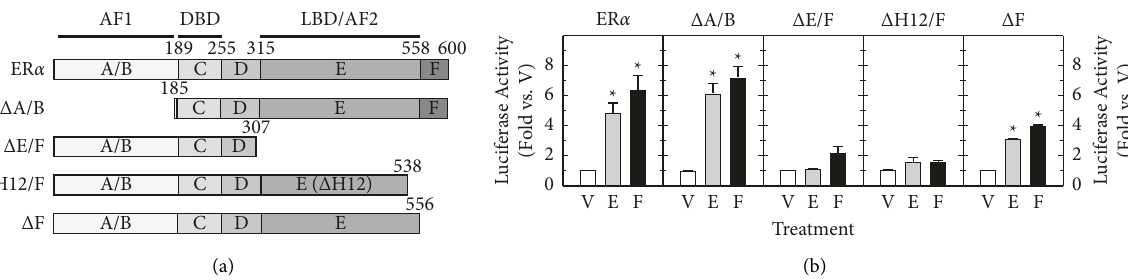
Figure 2: Forskolin increases ER α -mediated transcription via the ligand-binding domain (LBD). (a) The upper panel is a schematic representation of full-length rat ER α and deletion mutants used in this study. Key functional domains, including the activation function- 1(AF-1), the DNA-binding domain (DBD), and the LBD/activation function-2 (AF-2) are indicated on the top. (b) HT22 cells were similarly transfected with pGL3-2ERE luciferase reporter (500 ng) plus an expressing vector carrying wild-type or mutated ER α with deletion of A/B ( Δ A/B), E/F ( Δ E/F), helix12/F ( Δ H12/F), and F ( Δ F) (10ng) and treated either vehicle (V), estradiol (E, 10 nM), or forskolin (F, 1 μ M) for 24h. The luciferase activity (mean ± SEM) was normalized and expressed as fold stimulation over vehicle-treated groups carrying the same ER constructs (as 1 fold). ∗ , P < 0 . 05 vs. vehicle-treated groups with the same expression vector.